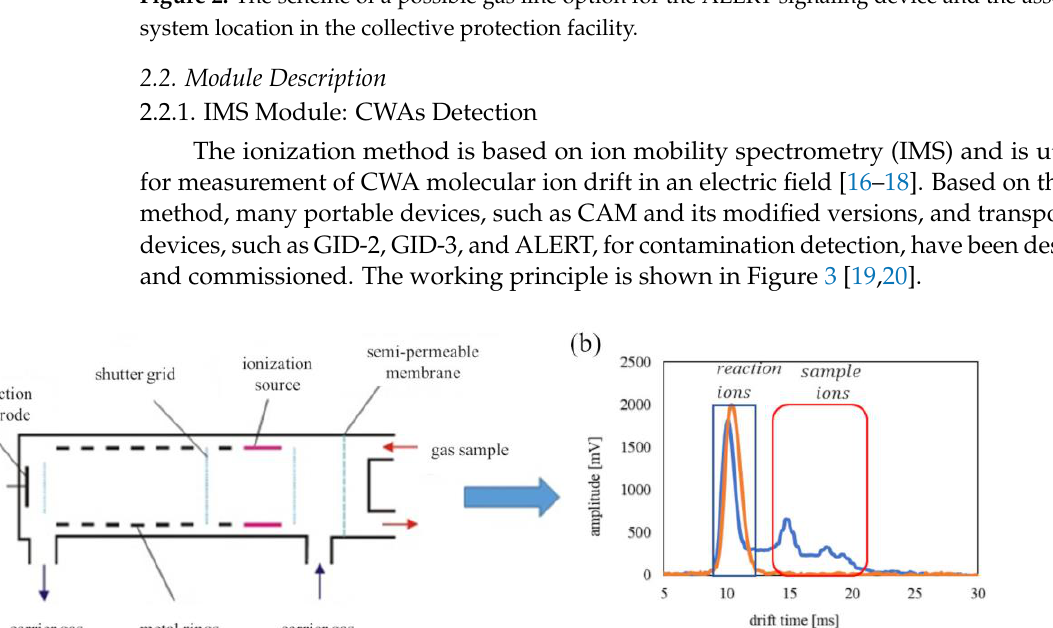
Figure 2. The scheme of a possible gas line option for the ALERT signaling device and the associated system location in the collective protection facility.